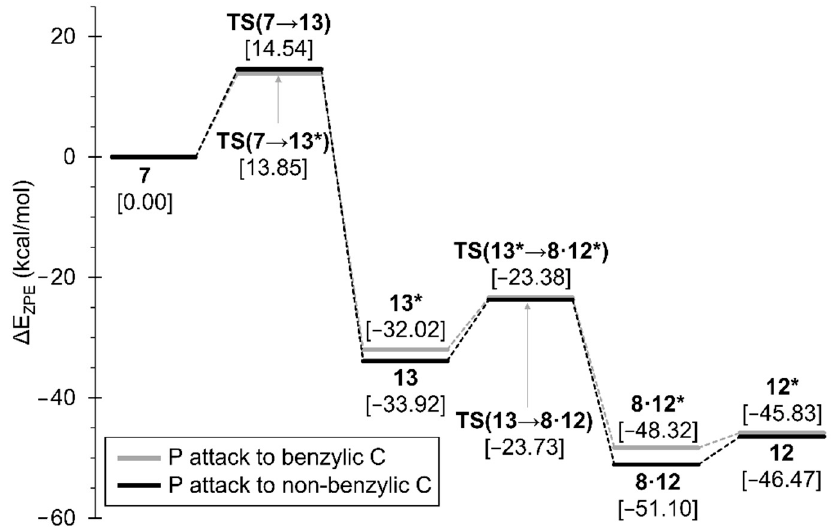
Figure 3. Calculated (CPCM THF /CCSD(T)/def2-TZVPP(ecp)) minimum energy profile for the con- version of 7 into 12 and 12* .